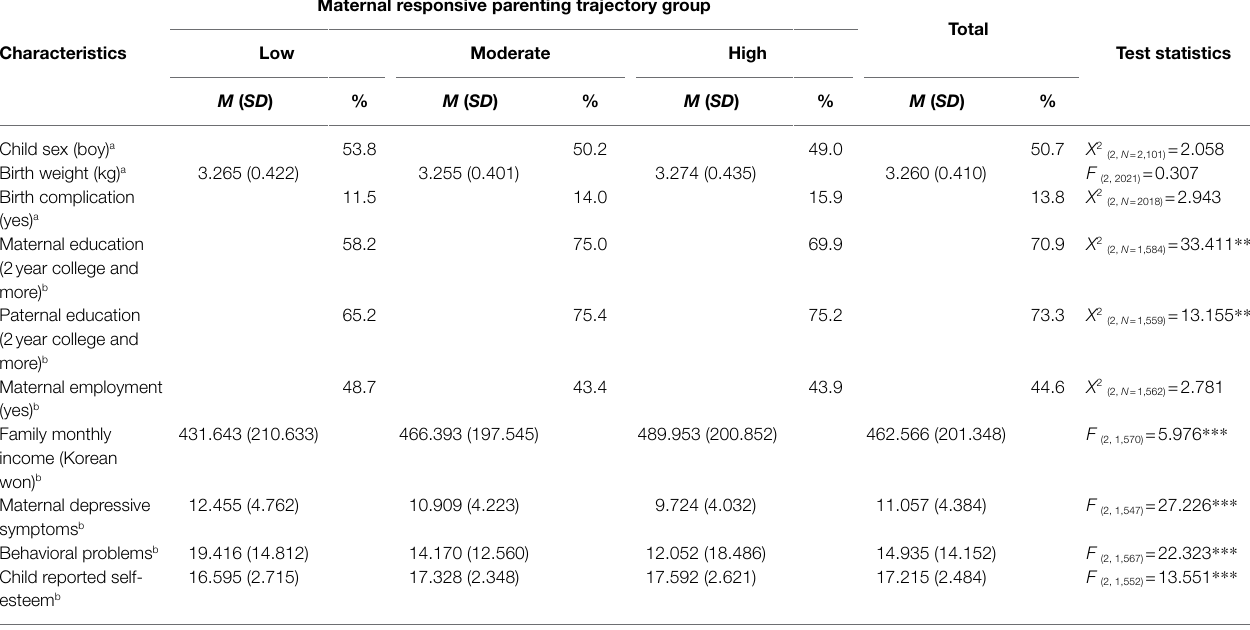
Maternal responsive parenting trajectory